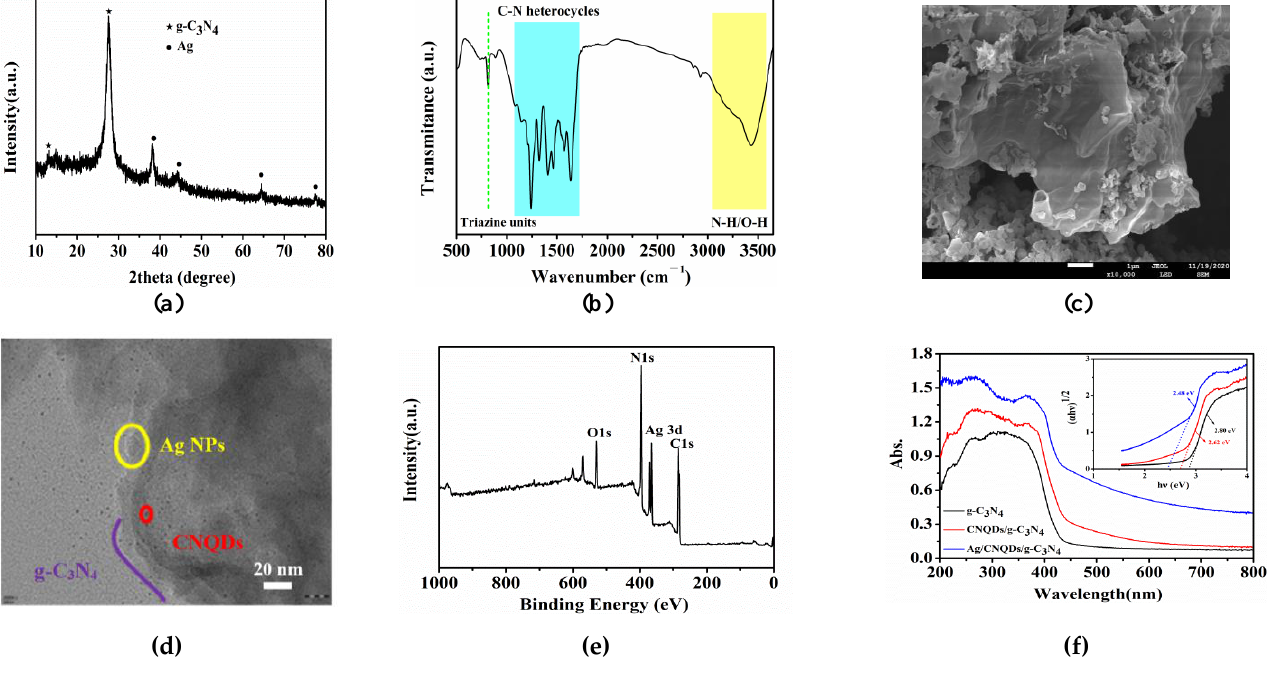
Figure 1. Characterization of Ag/CNQDs/g-C 3 N 4 composites: ( a ) XRD pattern; ( b ) FTIR spectra; ( c ) SEM image; ( d ) TEM image; ( e ) XPS spectra; ( f ) UV – vis diffuse reflectance spectra.